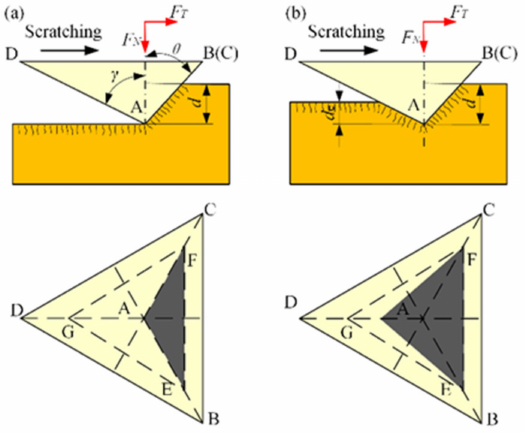
Figure 4. Diagram of the scratching process: ( a ) traditional analysis of normal force and ( b ) modified analysis of normal